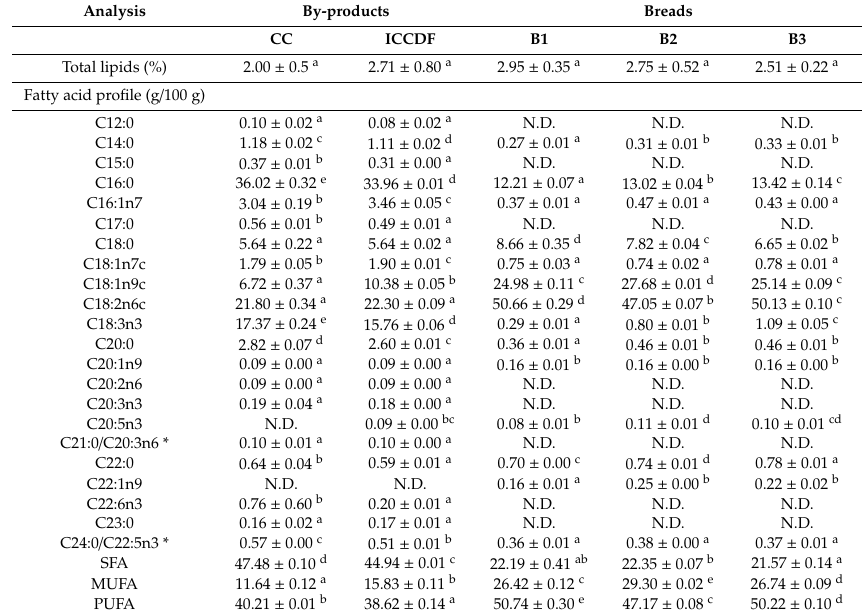
Table 3. Total lipids (%) and fatty acid content (g / 100 g of FA methyl esters) of cascara (CC), insoluble co ff ee cascara dietary fiber (IFCC) and breads enriched with ICCDF (B1, B2 and B3). Analysis By-products